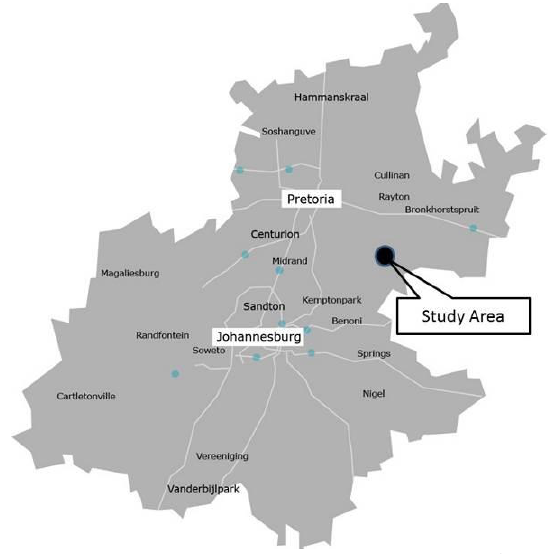
Figure 1. The Cors-Air study area to the east of Pretoria, Gauteng Province.